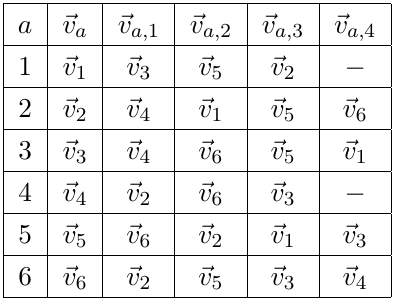
Table 8 . Vectors used to compute the master volume of the link of the SPP